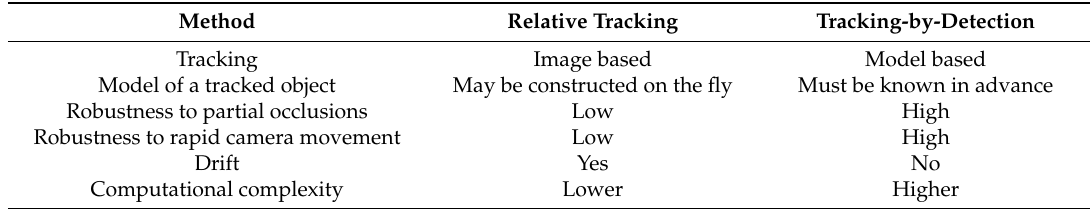
Table 1. Comparison of the relative and tracking-by-detection